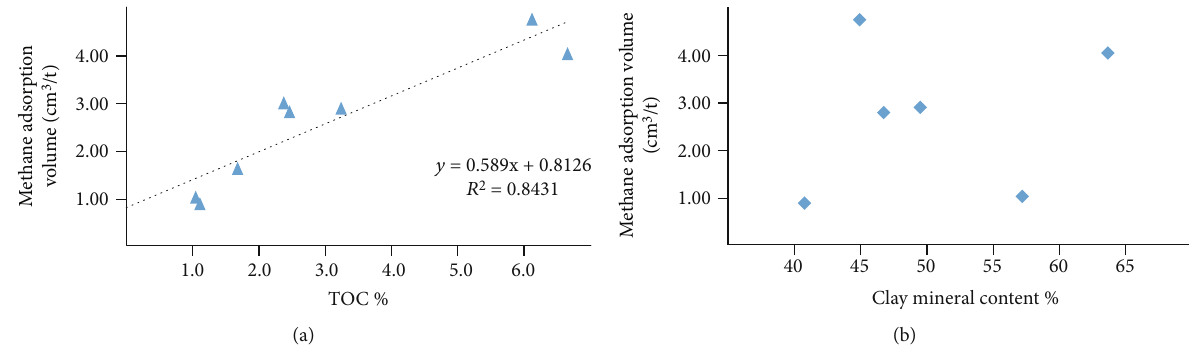
Figure 10: Relationship between methane adsorption and TOC, clay mineral